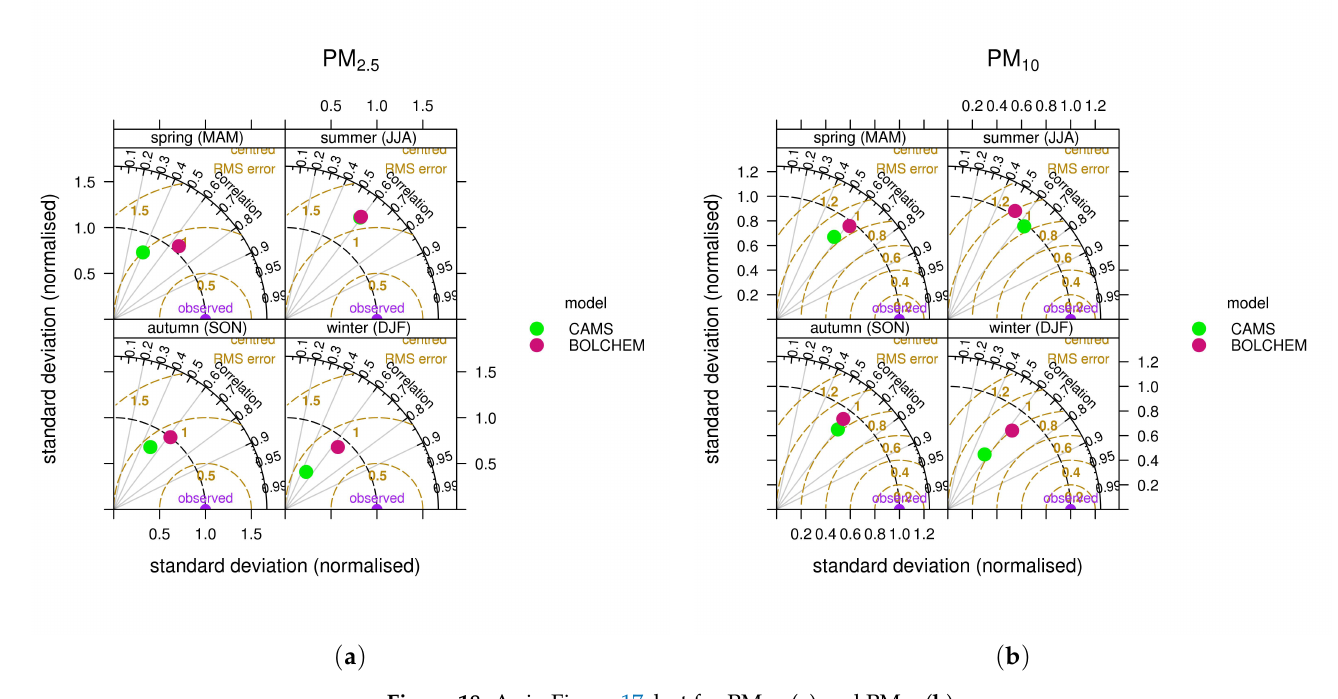
Figure 18. As in Figure 17, but for PM 2.5 ( a ) and PM 10 ( b ). Table 2. Basic statistics over italian domain at 0.1 ◦ resolution: correlation coefficient R, root mean square error RMSE ( µ g m − 3 ) and mean bias MB ( µ g m − 3 ) calculated for O 3 , NO 2 , PM 2.5 and PM 10 on seasonal basis for the background stations, both from BOLCHEM model and CAMS ensemble